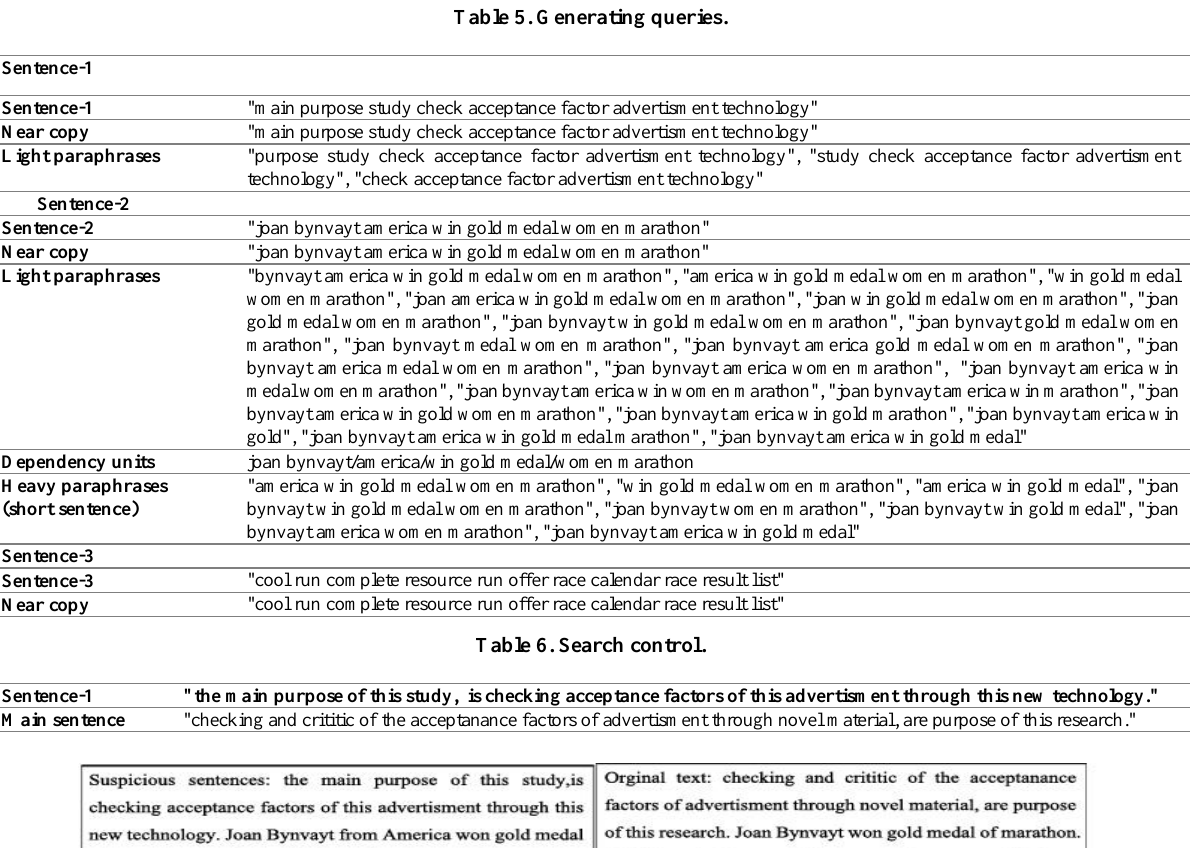
Table 5. Generating queries.